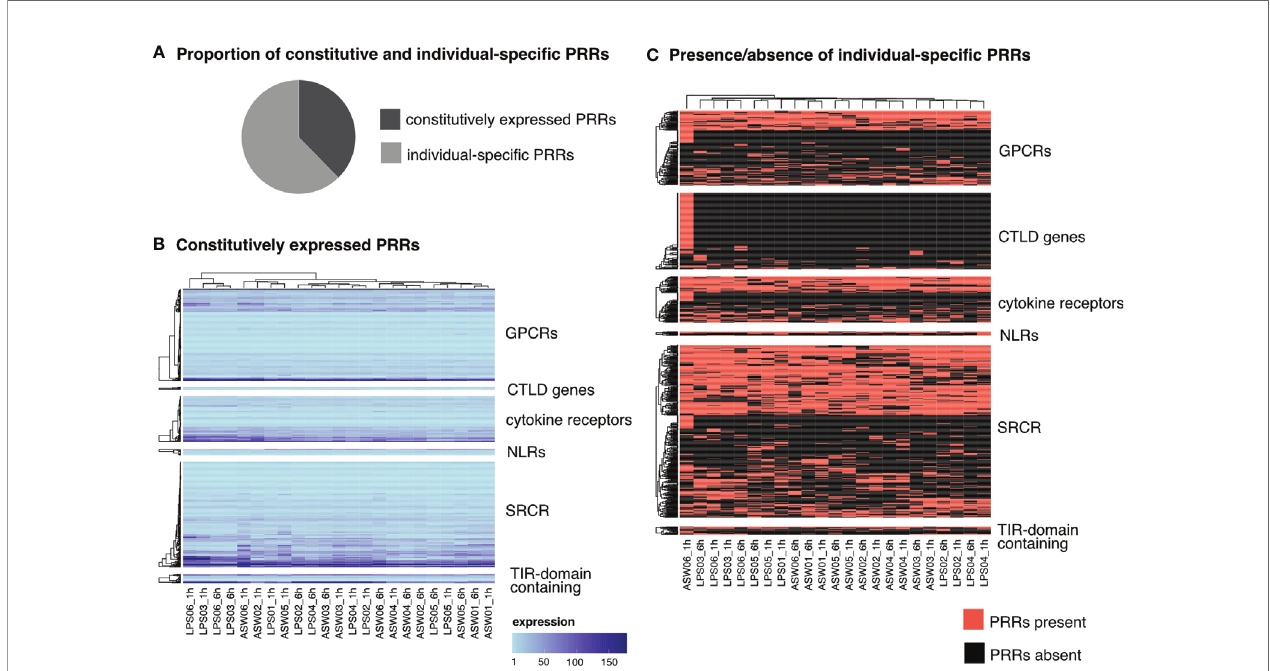
FIGURE 2 | Expression patterns of PRRs. (A) 38% of the identi fi ed PRRs were constitutively expressed (present in all samples), 62% were expressed individual speci fi c (PRRs present in only some samples). (B) Expression levels of constitutively expressed PRRs. Each row represents one gene and each column one sponge sample. The color gradient indicates the expression level (TMM normalized TPM). (C) Presence/absence of individual-speci fi c PRRs. Each row represents one gene and each column one sponge sample. Note the clustering of individuals independent of the timepoint (LPS01 was only sampled at 1h and not at 6h). PRR, pattern recognition receptor; GPCR, G-Protein coupled receptor; CTLD, C-type lectin like domain; NLR, nucleotide-binding domain and leucine-rich repeat containing receptors; SRCR, scavenger receptor cysteine-rich; TIR, Toll/interleukin-1 receptor.